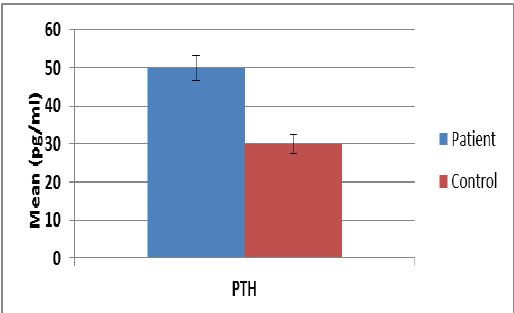
Figure 3. The mean serum PTH level (pg/ml) in FMS and control groups (P value<0.01)